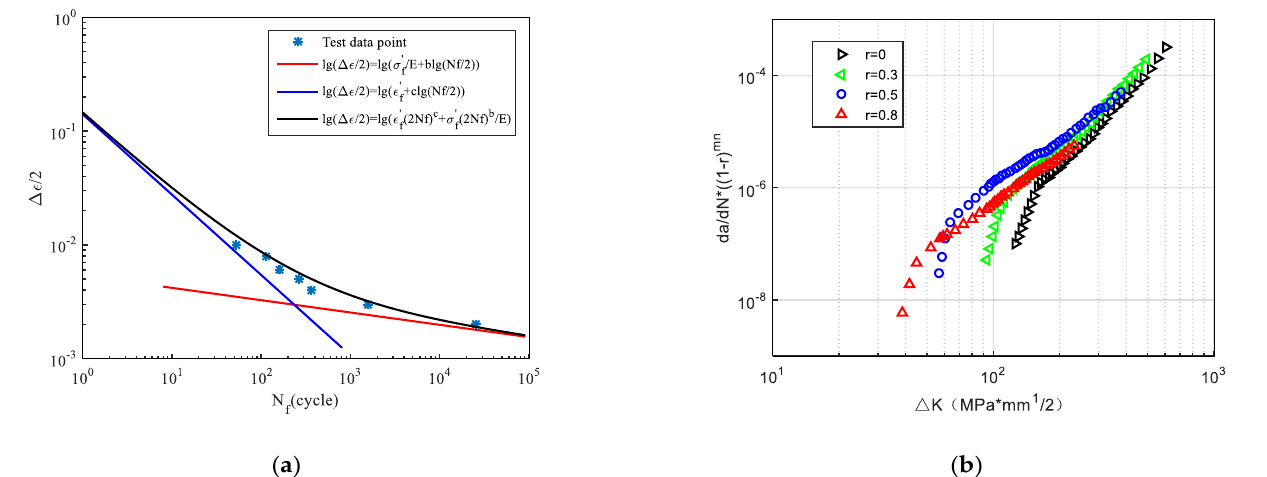
Figure 12. The fitting results of the Manson - Coffin and the Walker equations [54]. ( a ) The data fit for the Man- son - Coffin equation; ( b ) The data fit well for the Walker equation.